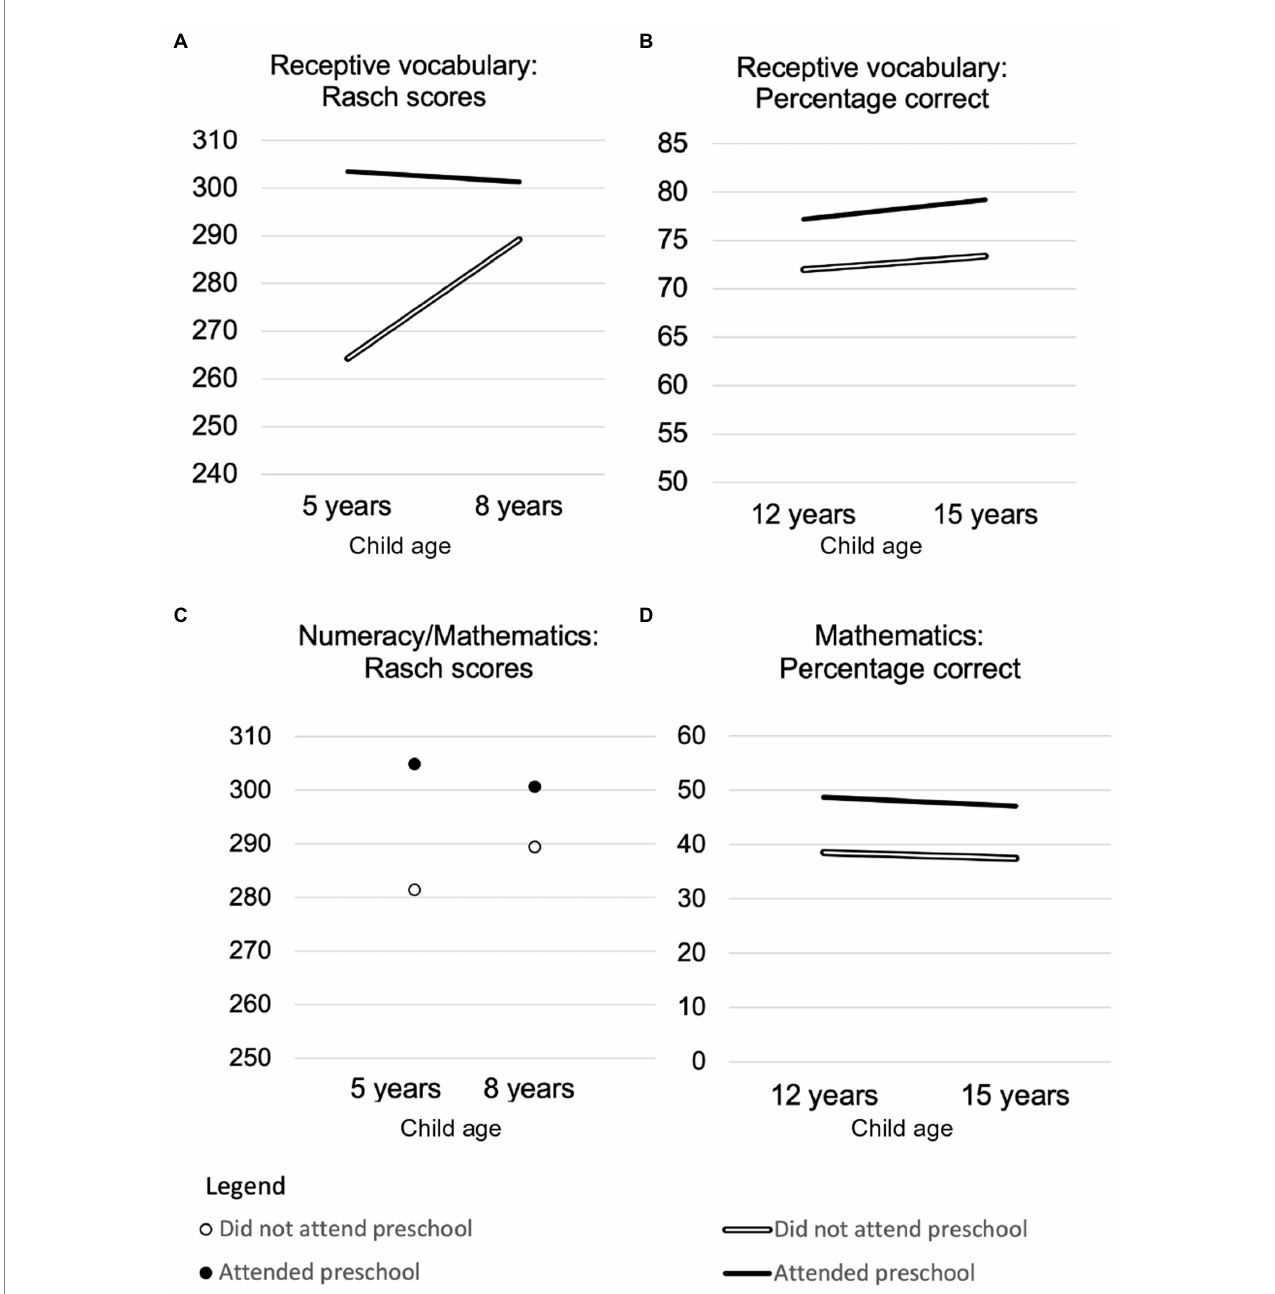
FIGURE 1 Longitudinal changes in cognitive outcomes at four ages for Vietnamese children who did ( n = 164) and did not attend preschool ( n =